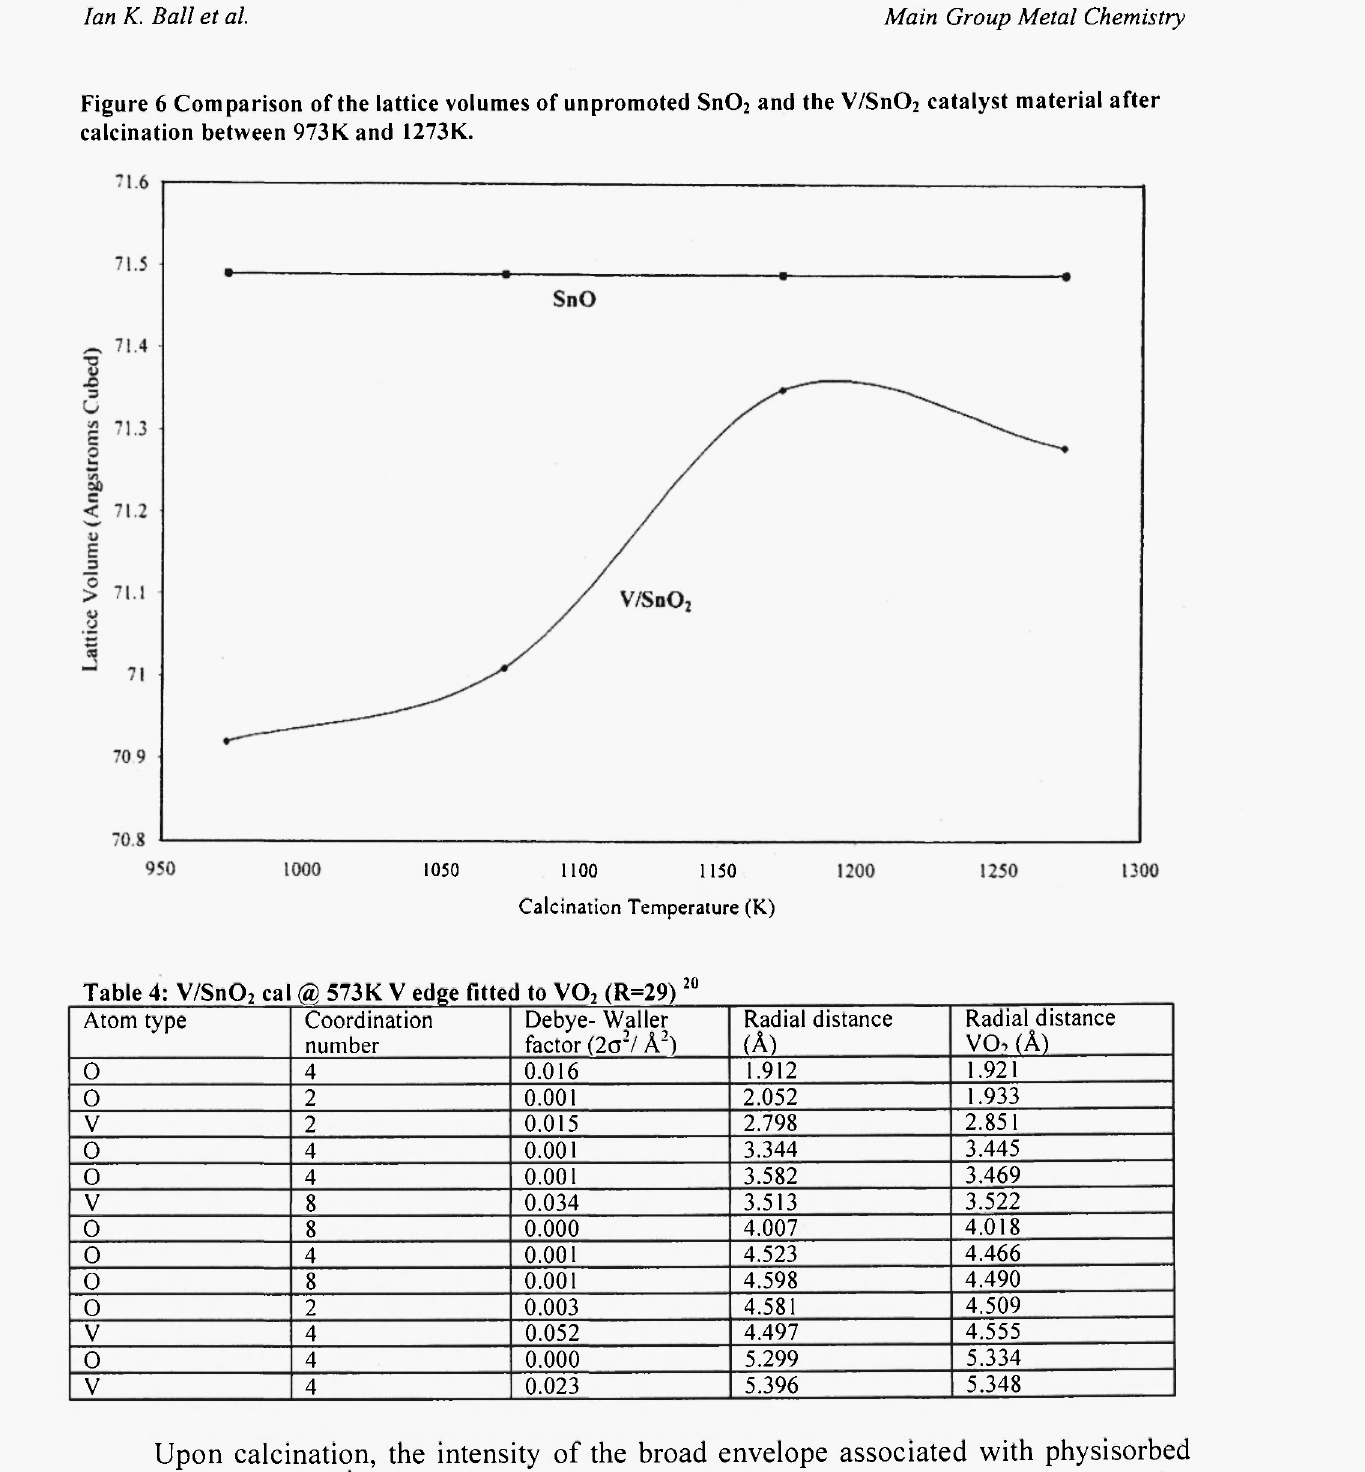
Figure 6 Comparison of the lattice volumes of unpromoted Sn0 2 and the V/Sn0 2 catalyst material after calcination between 973K and